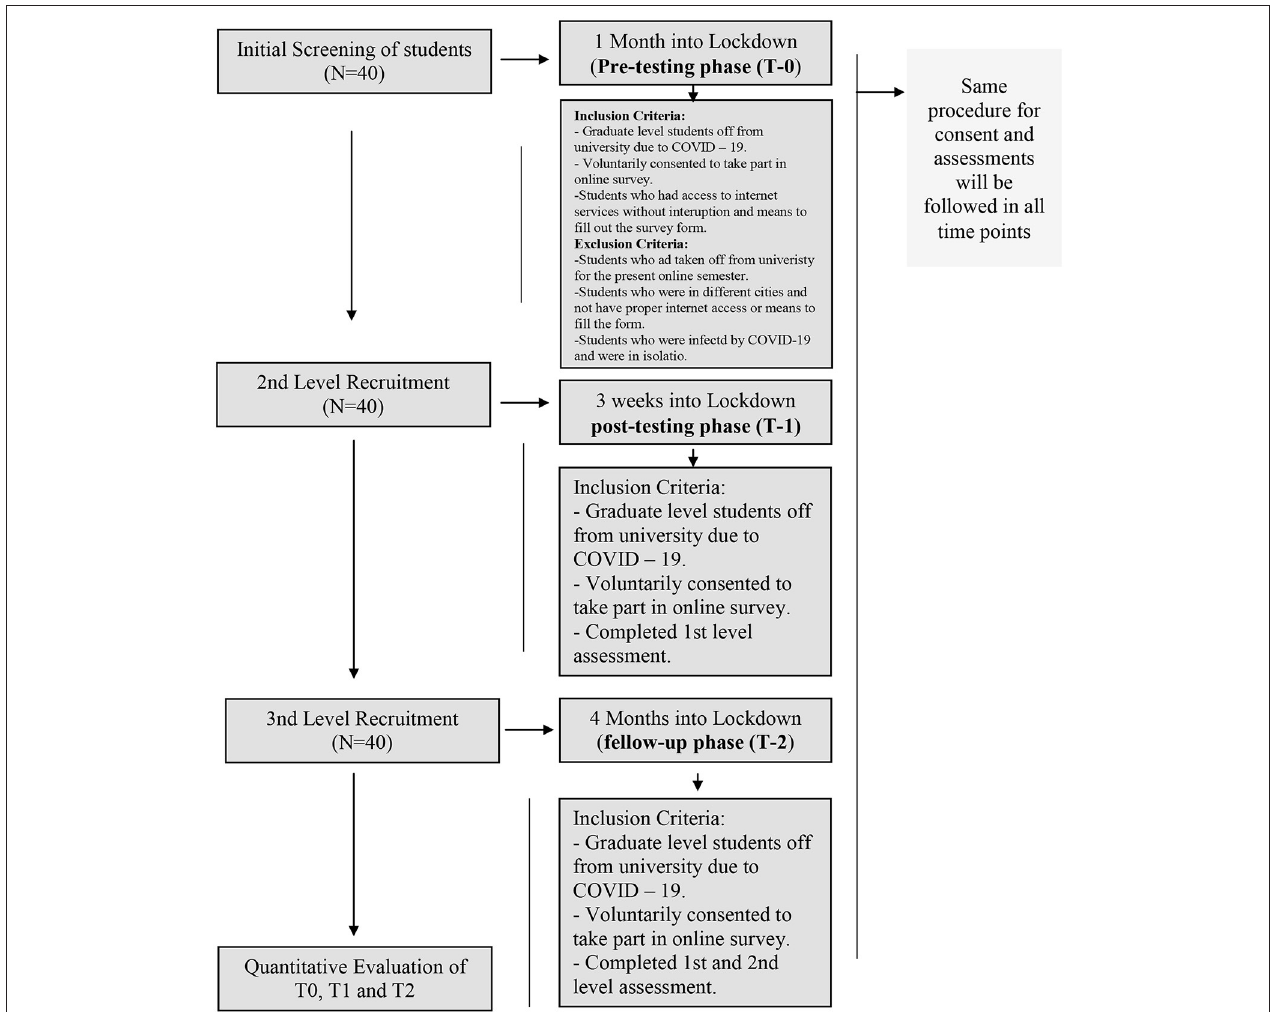
FIGURE 2 | Study flow chart of activities. Illustrative within-group, pretest–posttest design, quasi-experimental research for both full and partial lockdown